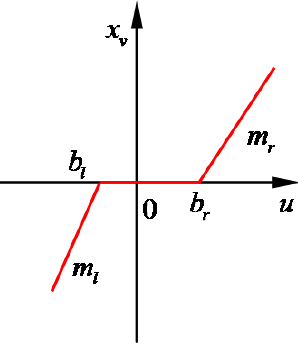
Figure 2. The valve dead-zone characteristics.